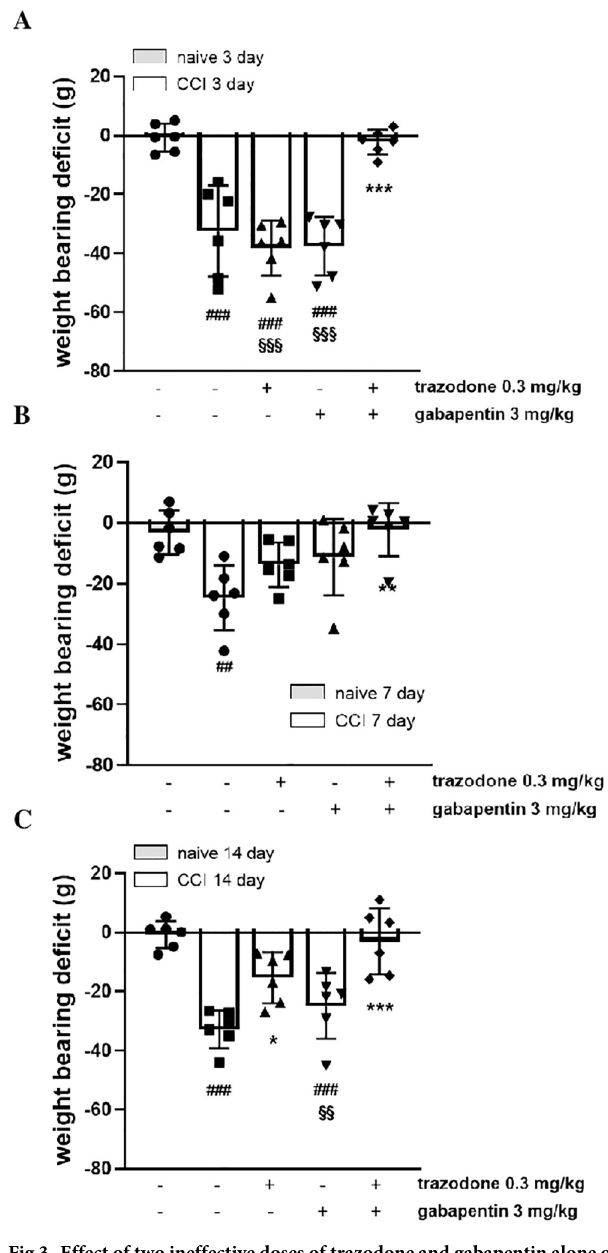
Fig 3. Effect of two ineffective doses of trazodone and gabapentin alone or in combination on weight bearing deficit 3 (A), 7 (B) and 14 (C) days following rat sciatic nerve ligation. The results are expressed as the difference between the contralateral and ipsilateral paws (in grams), calculated 1 h after treatment administration. ##P < 0.1, ###P < 0.001 vs na ï ve group; �� P < 0.01, ��� P < 0.001 vs vehicle CCI group; §§P < 0.01, §§§P < 0.001 vs trazodone- gabapentin CCI group. n = 6